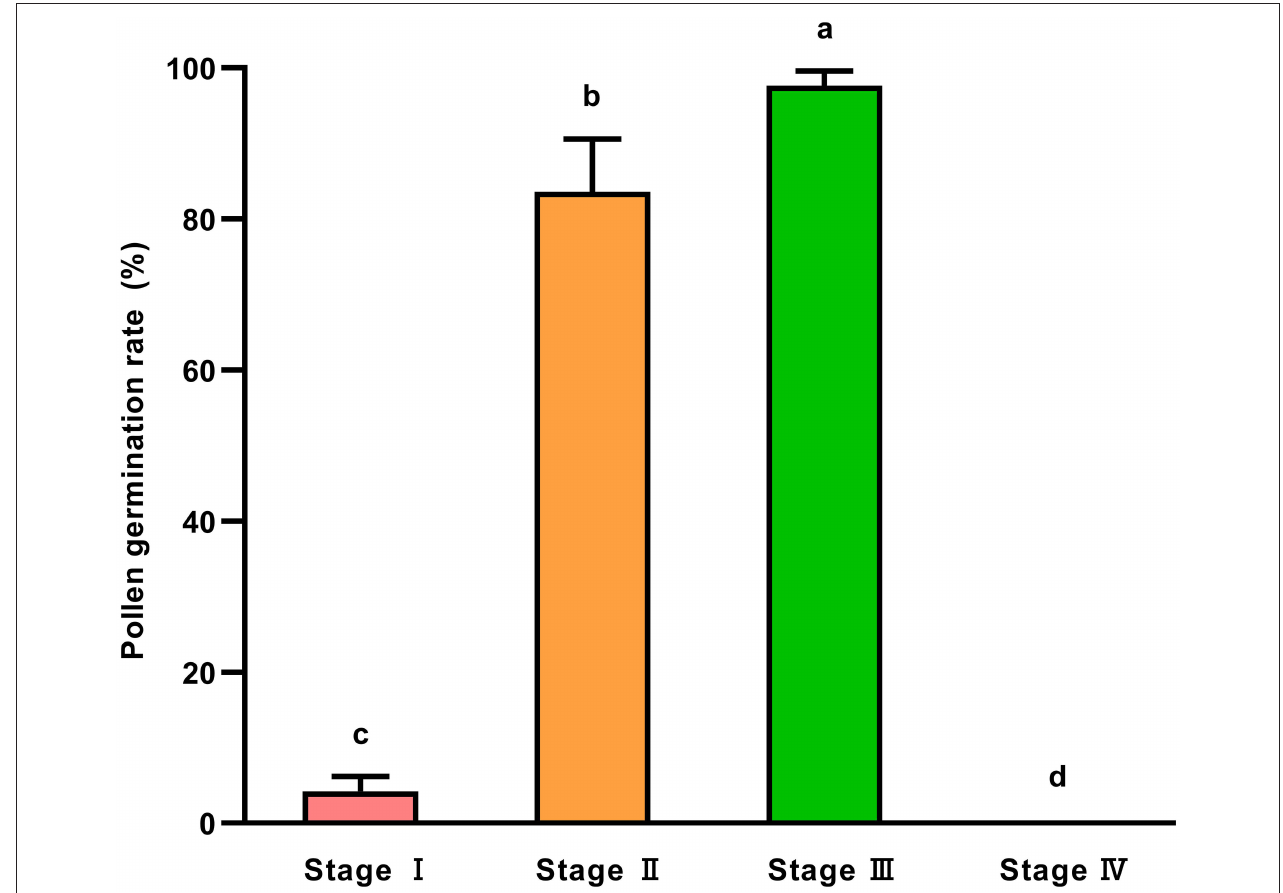
FIGURE 2 | Germination rate of fresh pollen at different developmental stages of soybean flowers. Stage I: Petal-emerging stage; Stage II: Petal-elongated stage; Stage III: Initially-open stage; Stage IV: Fully-open stage. All data were represented as mean ± SD of three replicates. Welch’s and Dunnett’s T3 methods were used to compare the means of germination rates of fresh pollen at different developmental stages of soybean flowers ( P <